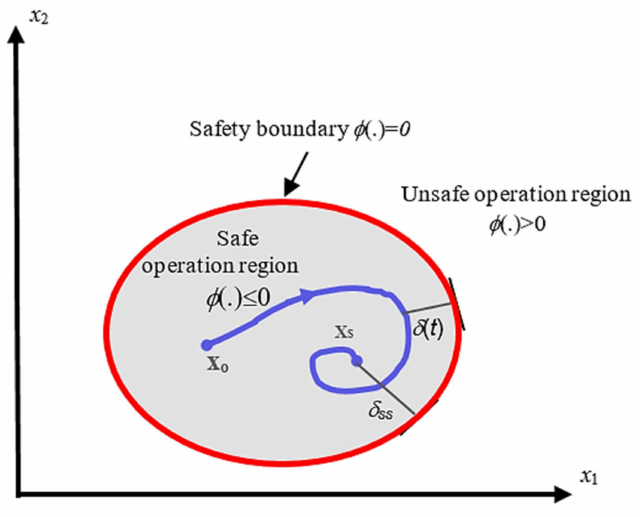
Figure 5. DSM definition.